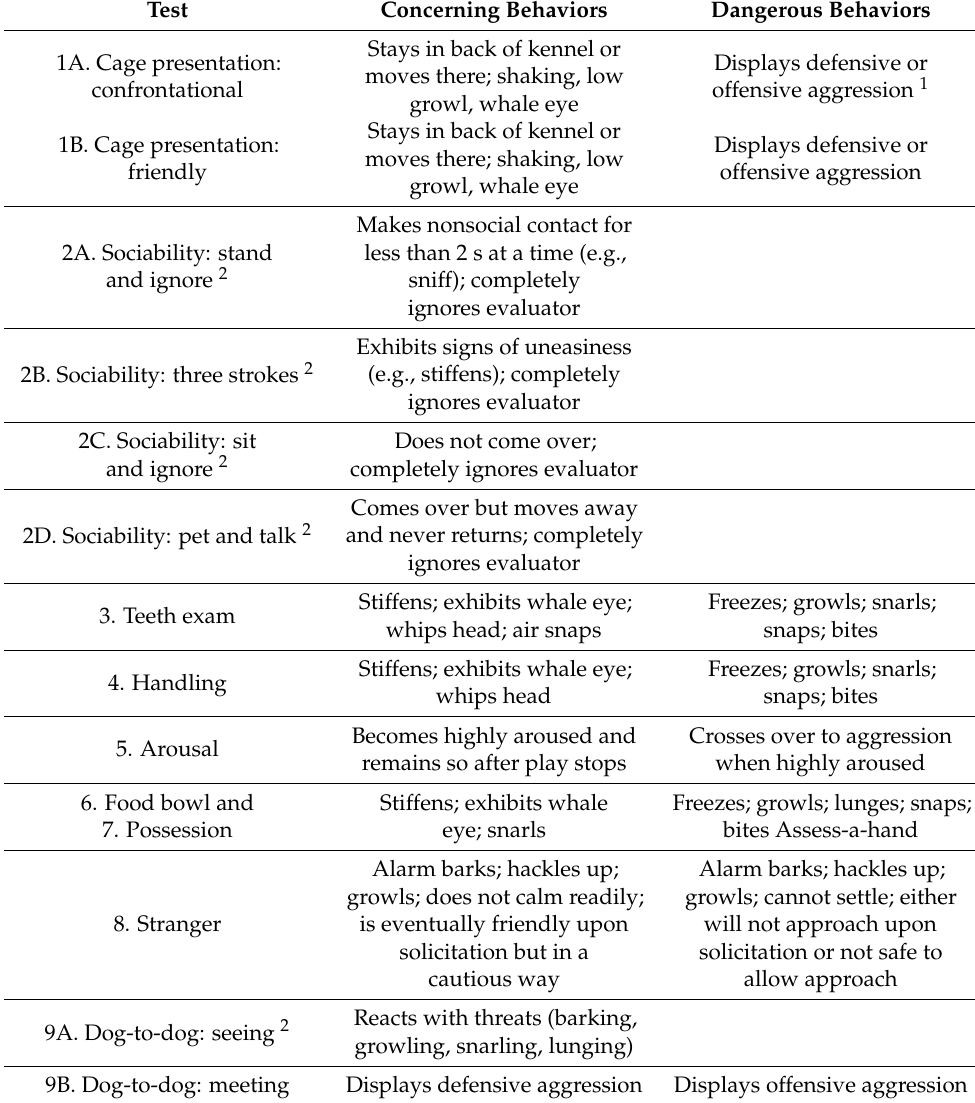
Table A1. Behaviors considered concerning or dangerous during canine behavioral evaluations at the study